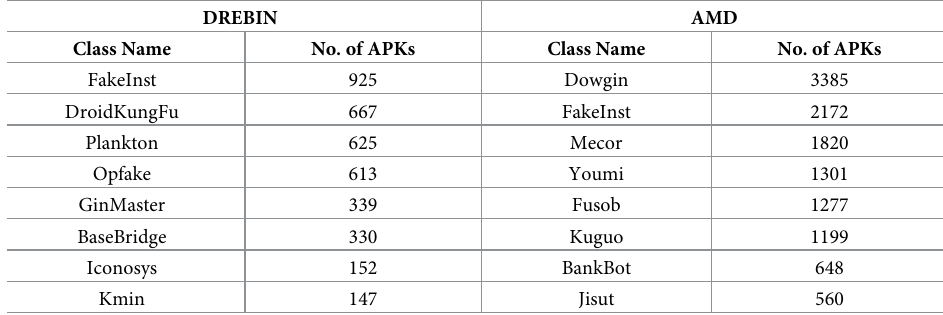
Table 4. Description of the examined android malware